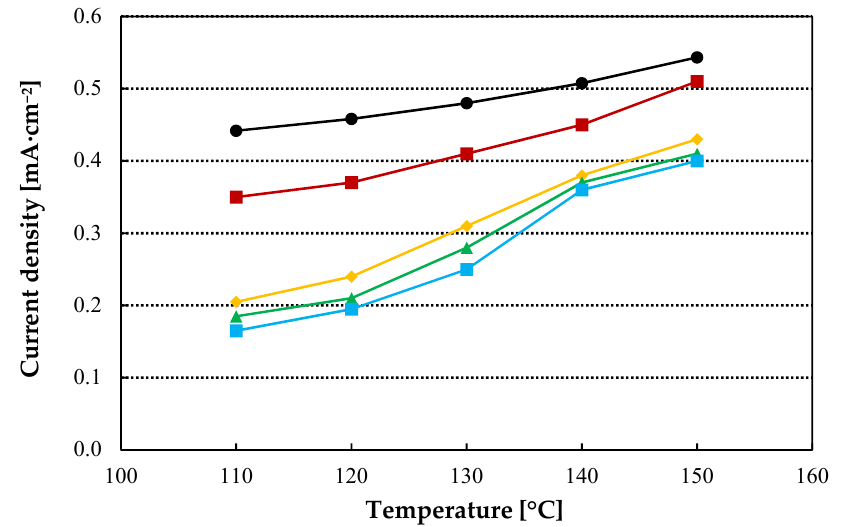
Figure 6. Crossover measurements for the pristine and TiO 2 -PBI composite membranes prepared in this work. Black line: Std-PBI; Red line: 0.5 wt% TiO 2 -PBI; Yellow line: 1.0 wt% TiO 2 -PBI; Green line: 2.0 wt% TiO 2 -PBI; Blue line: 3.0 wt% TiO 2 -PBI .